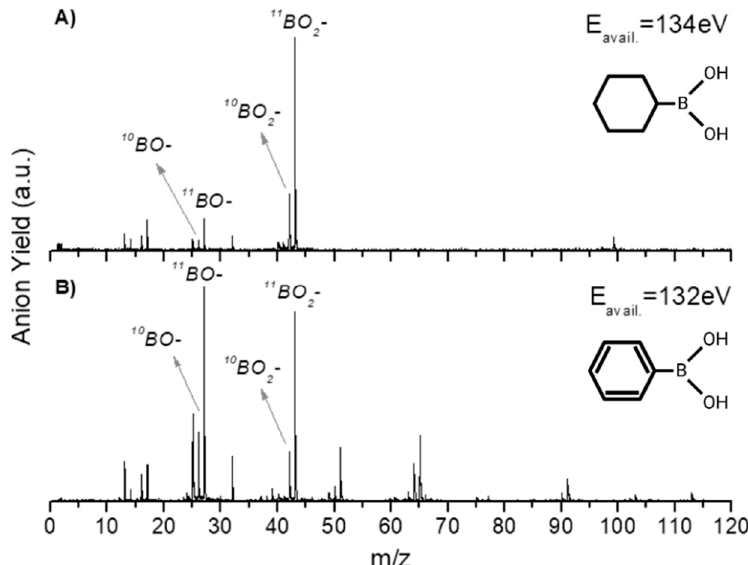
Figure 6. Comparison of time-of-flight negative ions’ mass spectra in neutral potassium collisions with CHBA (A) and PBA (B) at a 200 eV collision energy (~132 eV available energy).